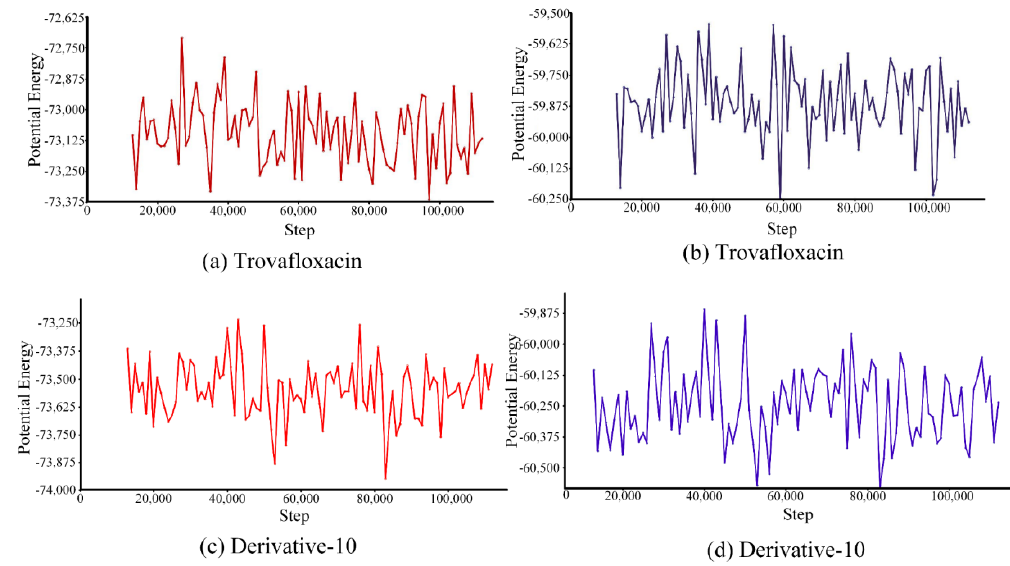
Figure 7. Potential energy and total energy trajectory of trovafloxacin and derivative-10 binding to plasma protein. ( a ): potential energy of trovafloxacin; ( b ): total energy of trovafloxacin; ( c ): potential energy of derivative-10; ( d ): total energy of derivative-10.